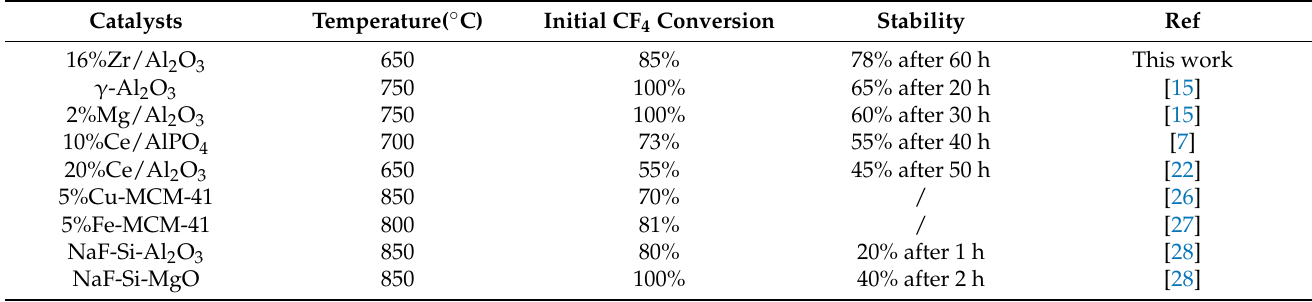
Table 3. Comparison of catalytic decomposition of CF 4 with other